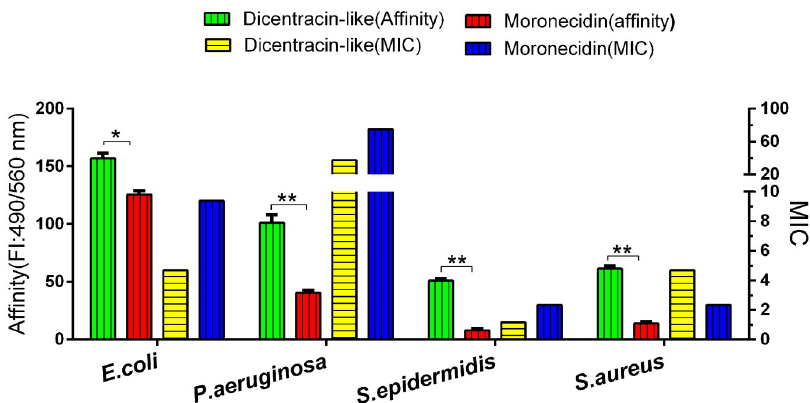
Fig 5. Comparison of the binding affinity of AMPs to gram-negative bacteria and gram-positive ones and their MICs ( μ g/ml). Binding affinity of moronecidin and dicentracin-like to bacteria was measured with a cell-based fluorometric ELISA. Fluorescence intensity (FI) of wells was measured on a microplate reader at excitation /emission (Ex/Em) = 490/560 nm. Binding affinity scores represent mean ± SD of three independent experiments. � : p � 0.01, �� : p � 0.001, and ns: p � 0 . 05